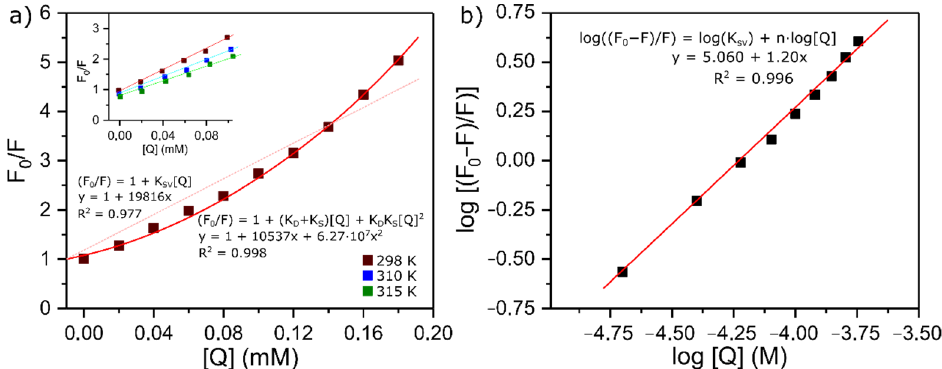
Figure 3. ( a ) Stern–Volmer plots for the quenching of lysozyme by BTS. Insert: Quenching at low concentrations and different temperatures (298, 310, 315 K); C lysozyme = 0.02 mM. ( b ) Plots of log[(F 0 − F)/F] vs. log [Q]. Numerical results of the fittings are presented in the graphs.